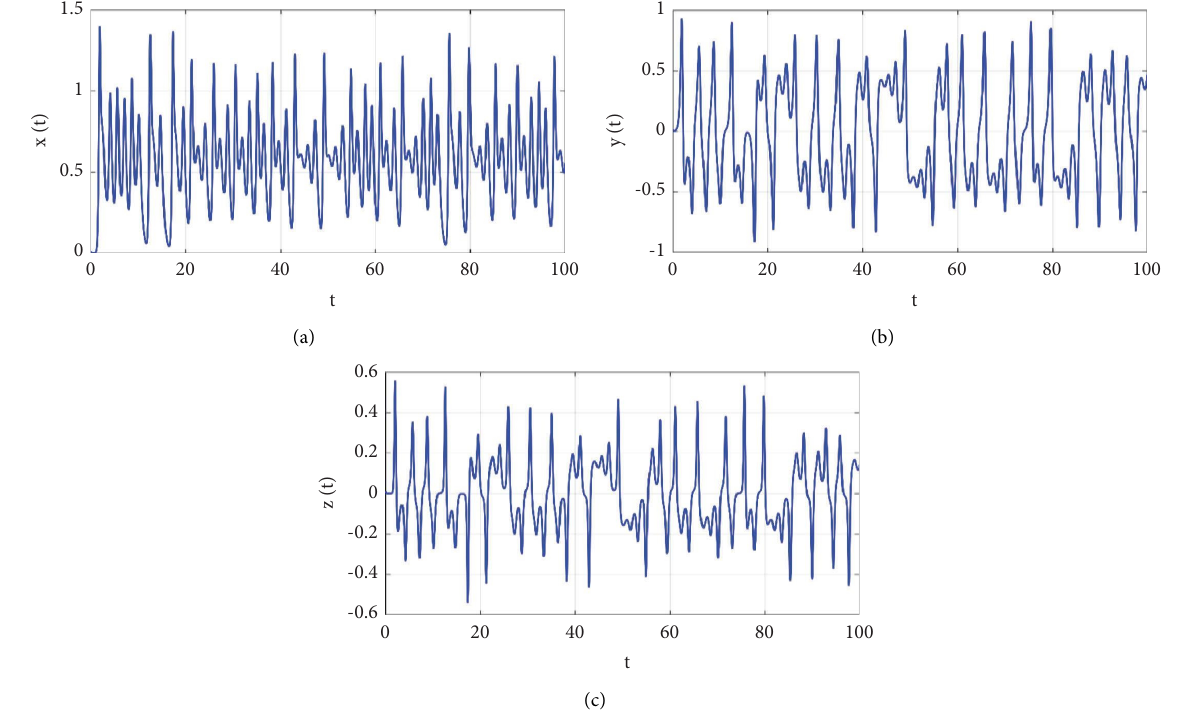
Figure 2: (a–c) Time response of the proposed chaotic system at x ( 0 ) � y ( 0 ) � z ( 0 ) � 0 . 01, a � 2 , b � 7 , c � 5 ,f � 8 ,g � 11 , and r �